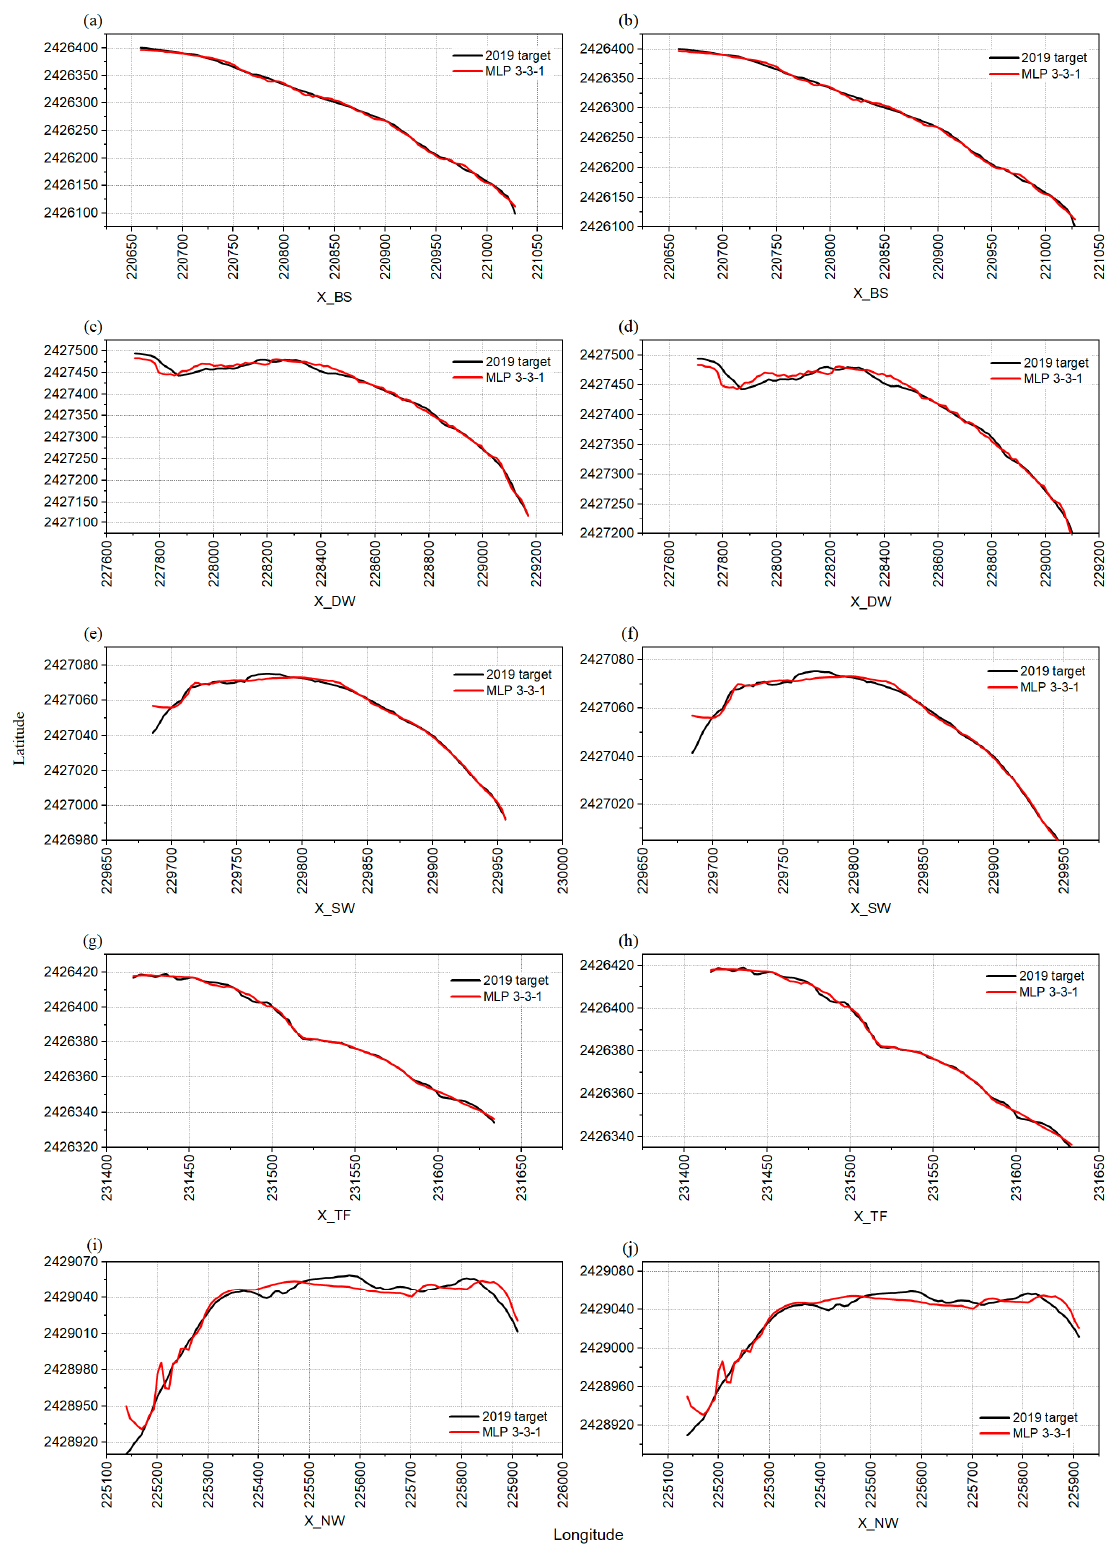
Figure 5. Observed and predicted shoreline changes in training ( a , c , e , g , i ) and testing ( b , d , f , h , j ) phases of the best performing activation functions (Logistic and Tahn).